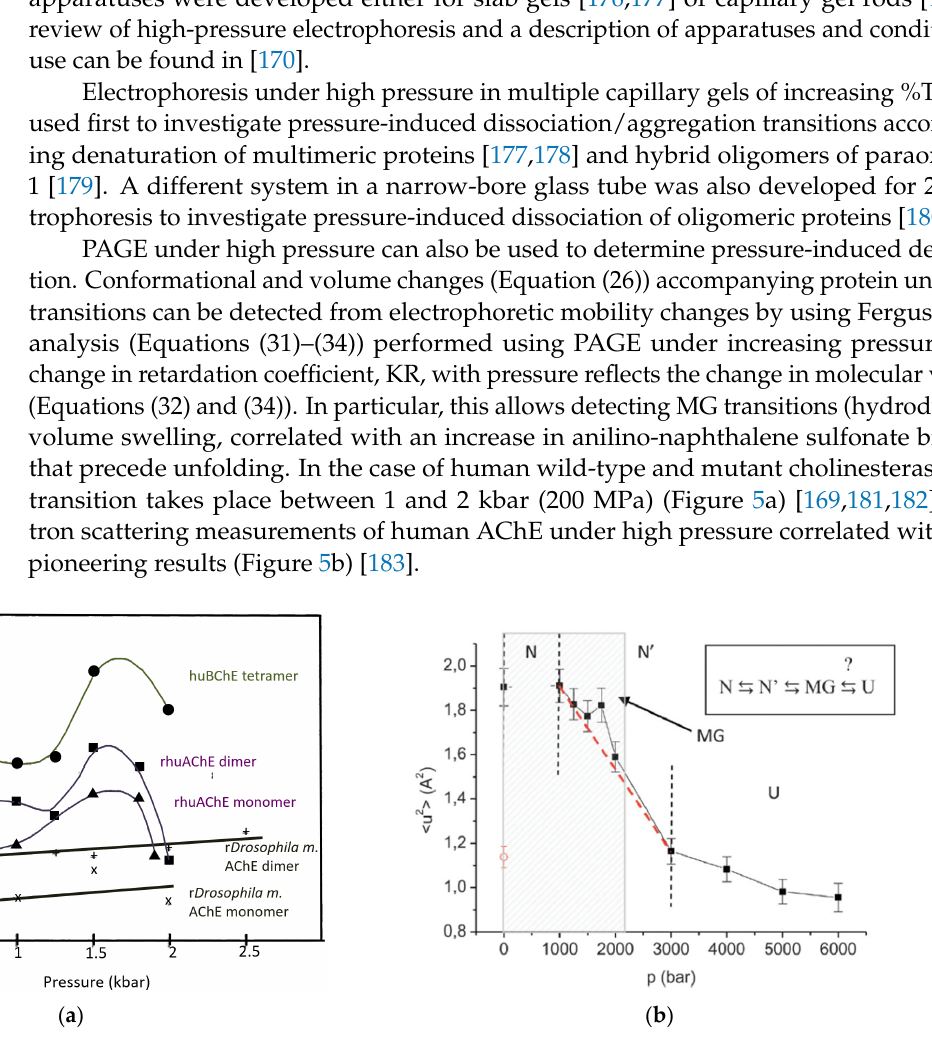
Figure 5. Pressure-induced molten globule (MG) transition of cholinesterases. ( a ) PAGE under high pressure: change in the retardation coefficient ( K R ) of different cholinesterases with high pressure in 8.26 mM Tris/Gly pH 8.3 at 10 °C (redrawn from [181] ; ( λ ) human BChE tetramer; ( ν ) human AChE dimer; ( ) human AChE monomer; ( ) recombinant Drosophila melanogaster AChE dimer; (+) recombinant Drosophila melanogaster AChE monomer). Although all ChEs have the same fold, unlike human ChEs, the Drosophila enzyme that has low sequence homology with human enzymes does not show the MG transition around 1.5 kbar. ( b ) Neutron scattering of human AChE (reproduced from [183] with permission from the Royal Society of Chemistry). Mean square displacement (MSD) as a function of pressure, the MG transition is at 1.75